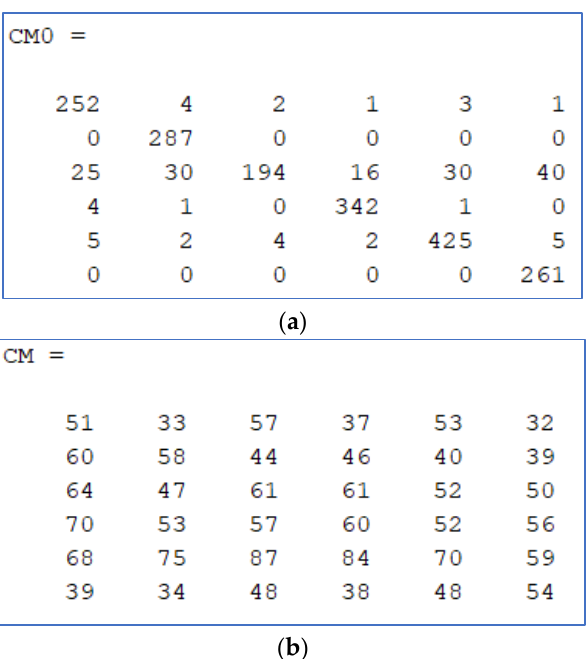
Figure 6. Confusion matrix samples: ( a ) no attack; ( b ) preferred combined method (method H ).